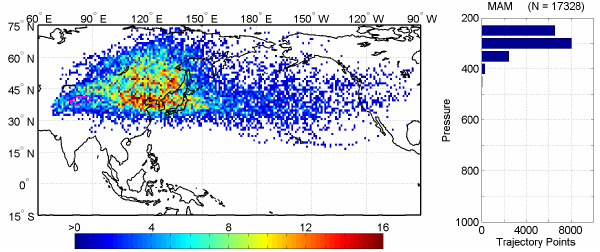
Fig. 11. WATER cloud points originating from West African dust sources (shown in magenta) in JJA.